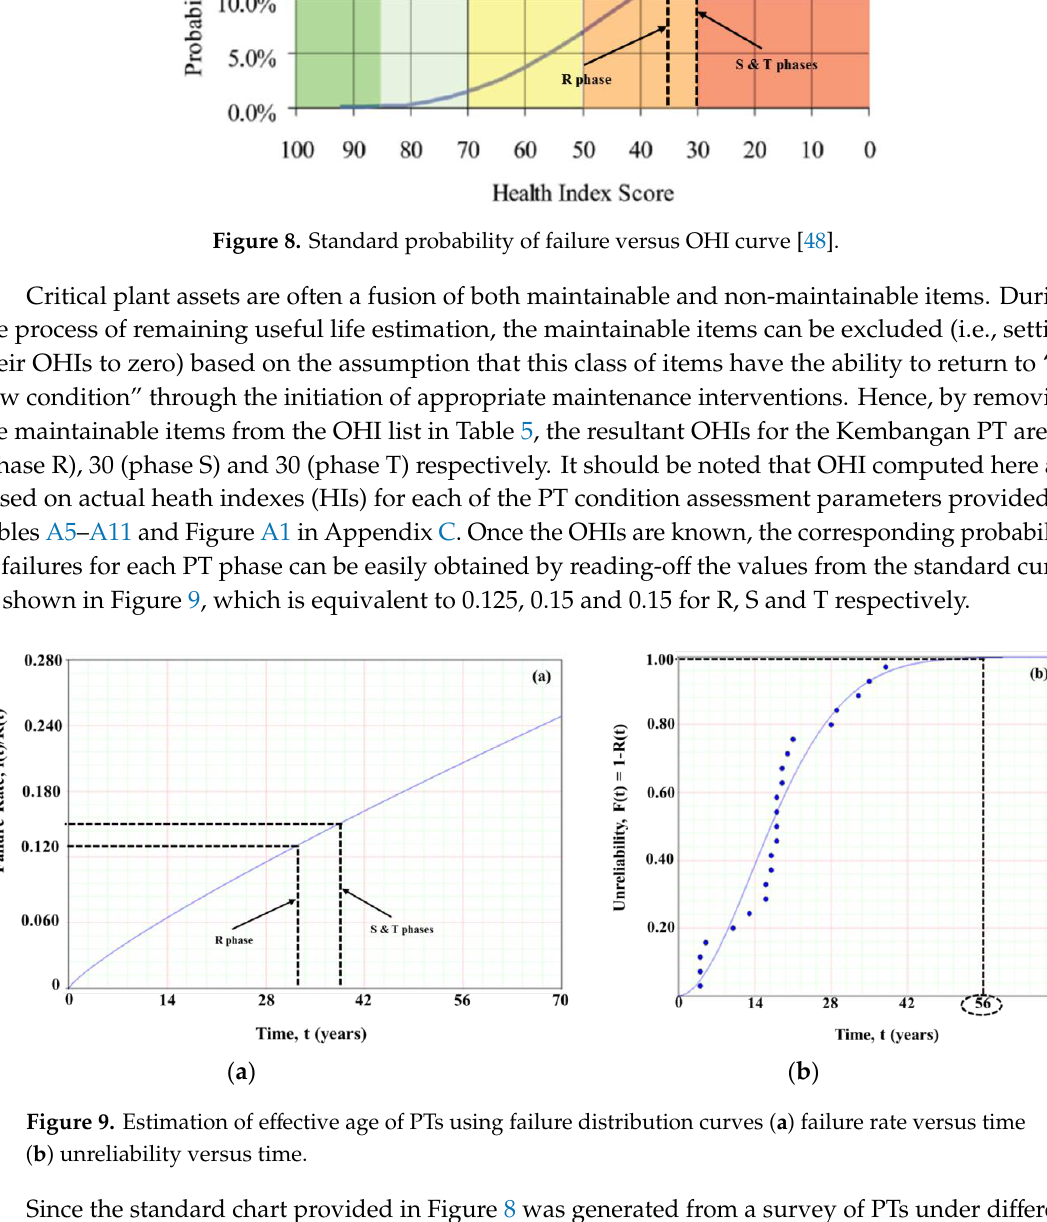
Figure 9. Estimation of effective age of PTs using failure distribution curves ( a ) failure rate versus time ( b ) unreliability versus time.